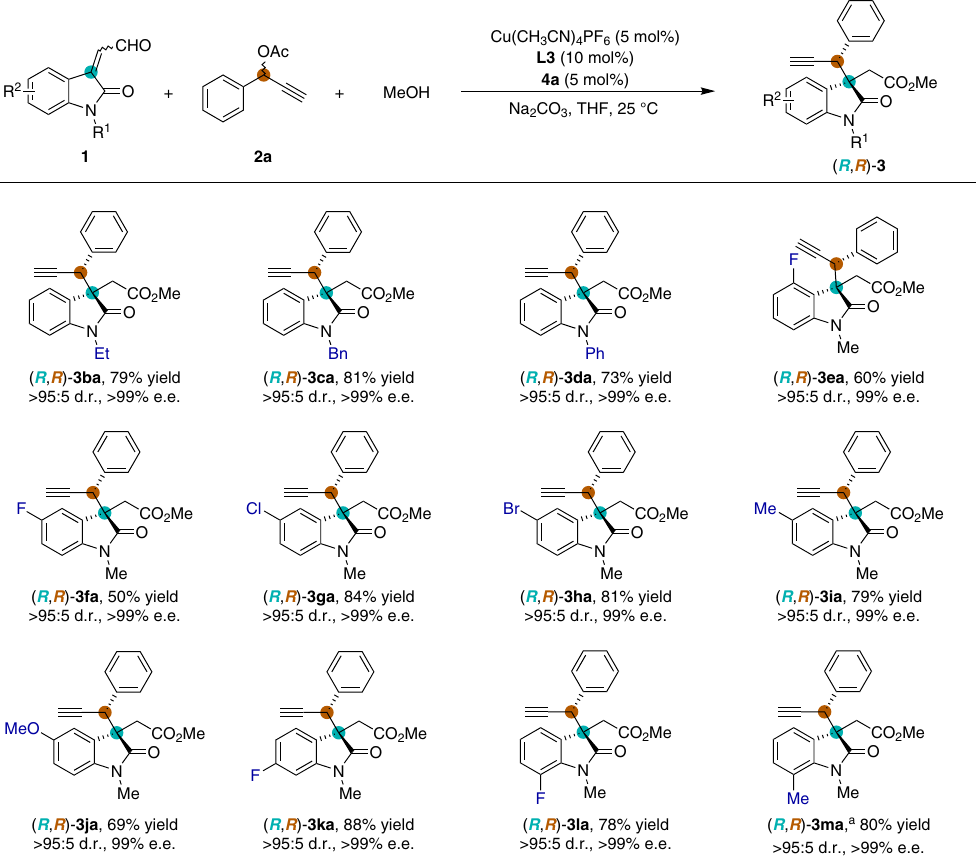
Fig. 2 Substrate scope of isatin-derived enals. Reaction conditions: Cu(CH 3 CN) 4 PF 6 (5 mol%) and pyridine bis(oxazoline) ligand L3 (10 mol%) were stirred in THF (0.5 mL) at 25 °C for 1 h, then NHC precatalyst 4a (5 mol%), 1 (0.15 mmol), 2a (0.1 mmol), MeOH (0.5 mmol), Na 2 CO 3 (0.1 mmol) and THF (0.5 mL) were added to the reaction mixture and stirred for 12 h under N 2 . Diastereomeric ratio (d.r.) was determined by 1 H NMR spectroscopic analysis. Isolated yields. The enantiomeric excess (e.e.) was determined by HPLC. a 7.5 mol% of 4a was